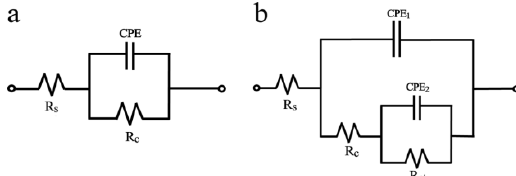
7 of 13 Figure 5. ( a ‒ d ) Nyquist plots of electrochemical impedance spectroscopy (EIS) (dots) and fits of a ZsimpWin (version 3.60, lines) operated immersed in a 3.5% NaCl solution at room temperature (25 °C). The R 2 values from EIS data of bare zinc, Sample 1, Sample 2, Sample 3, Sample 4, Sample 5 and Sample 6 were 0.9625, 0.9376, 0.9967, 0.9025, 0,9499 and 0.9448, respectively. The equivalent circuits are shown in Figure 6. The corresponding electrochemical parameters extracted by fitting EIS plots with the Zsimpwin program are summarized in Table 2. CPE is a constant phase element, and CPE 1 and CPE 2 are used in place of coating capacitance and double-layer capacitance in order to give more accurate fits to the experimental results. R c is attributed to the pore resistance and signifies the performance of the surface coating [15,27], which is inversely proportional to the defects (pores) in a film. Its value can be taken as a measure of the porosity and the degree of degradation of a coating film. The R c values for different samples are shown in Table 2. A low R c (395 Ω cm 2 ) for bare zinc indicates the presence of a porous layer of corrosion product on its surface. For this reason, chloride ions continually diffuse to the metal surface, causing a decreased R c . The measured R c of zinc coated